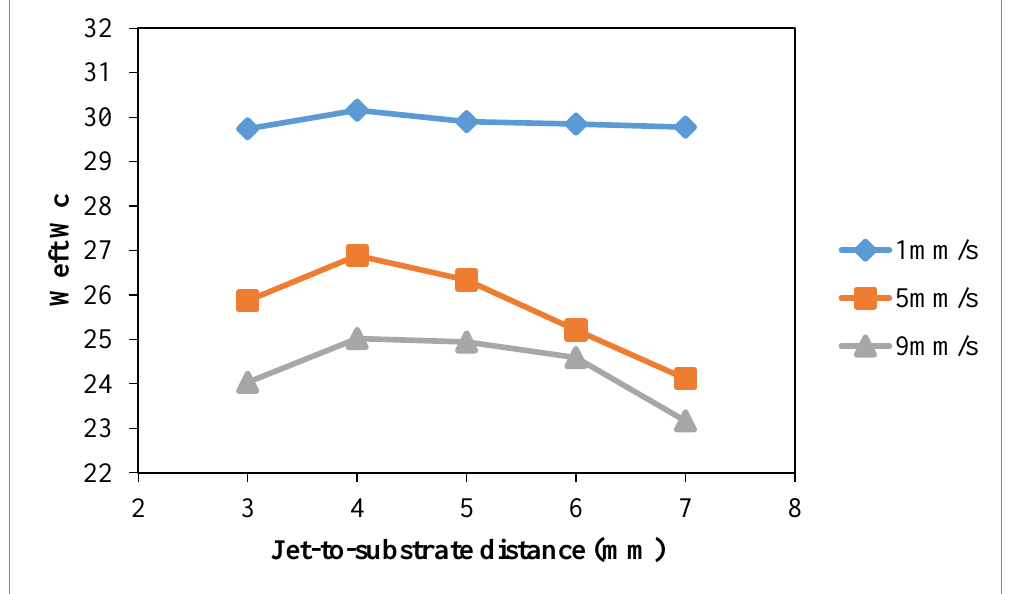
Figure 15. Effect of jet-to-substrate distance weft W c (Jet-to-substrate distance: 3 mm, 4 mm, 5 mm, 7 mm and 9 mm; Jet travelling speed: 1 mm/s, 5 mm/s, 9 mm/s; Discharge power: 150 W and Oxygen flow rate: 0.4 L/min).